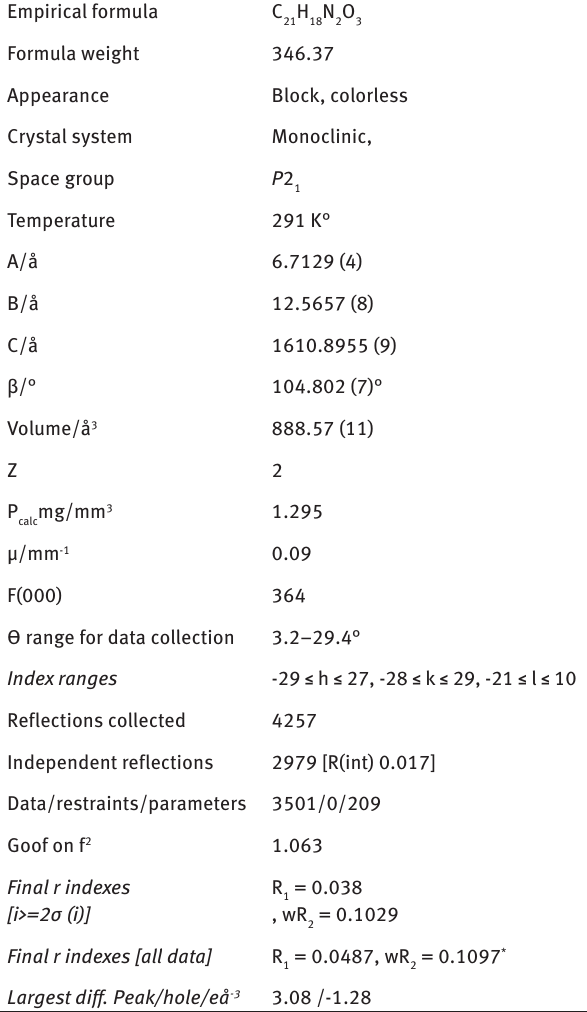
Table 1: Crystal data and structure refinement for compound